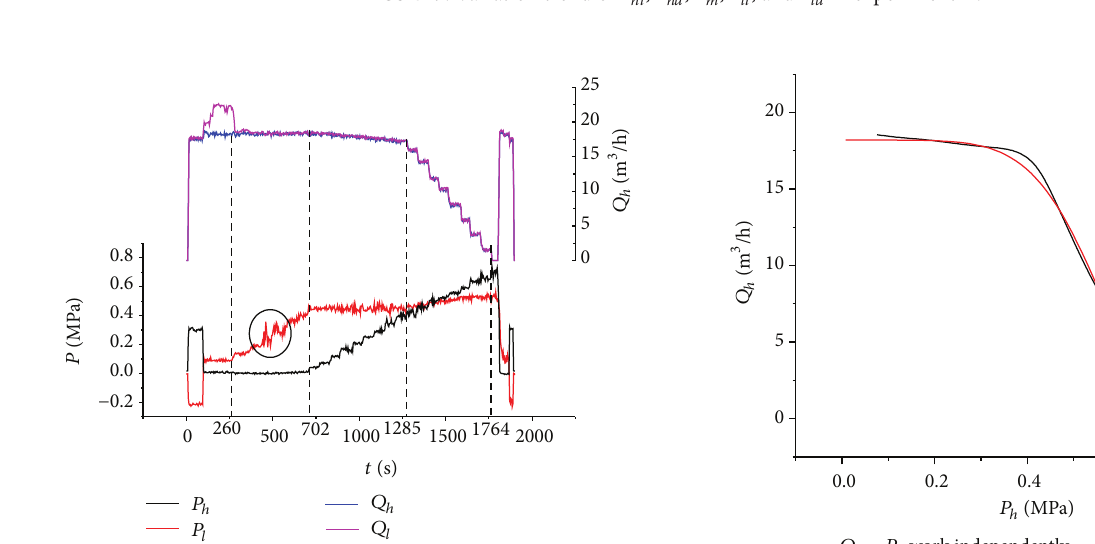
Figure 7: Variation trend of 𝑃 ℎ𝑖 , 𝑃 ℎ𝑢 , 𝑃 𝑚 , 𝑃 𝑙𝑖 , and 𝑃 𝑙𝑢 in experiment II.